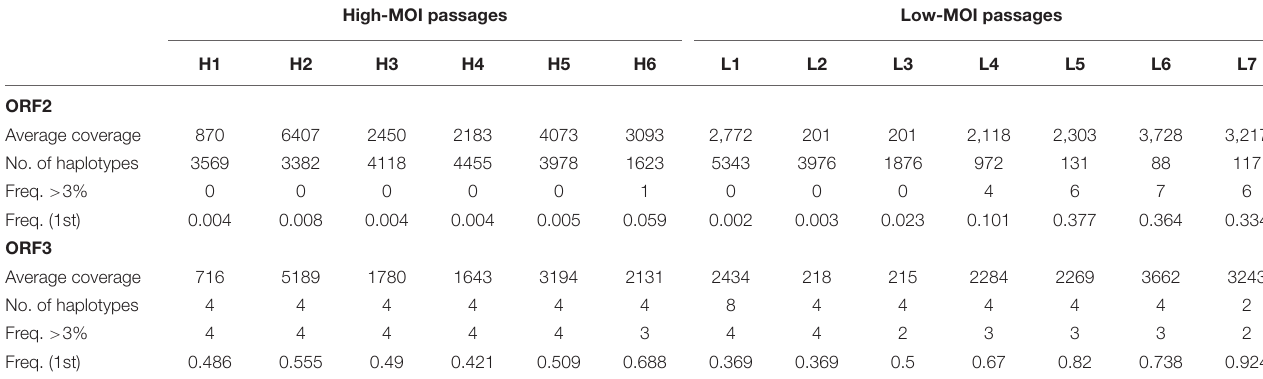
PP3-mediated virus production in one experiment ( Figure 5B , f ), but in two other experiments infectious virus was not produced from PP3 genome with the presence of ORF1 PP2 genome. In contrast, co-transfection of the PP3 genome and ORF23 PP2 generated infectious particles ( Figure 5B , g ), as did that